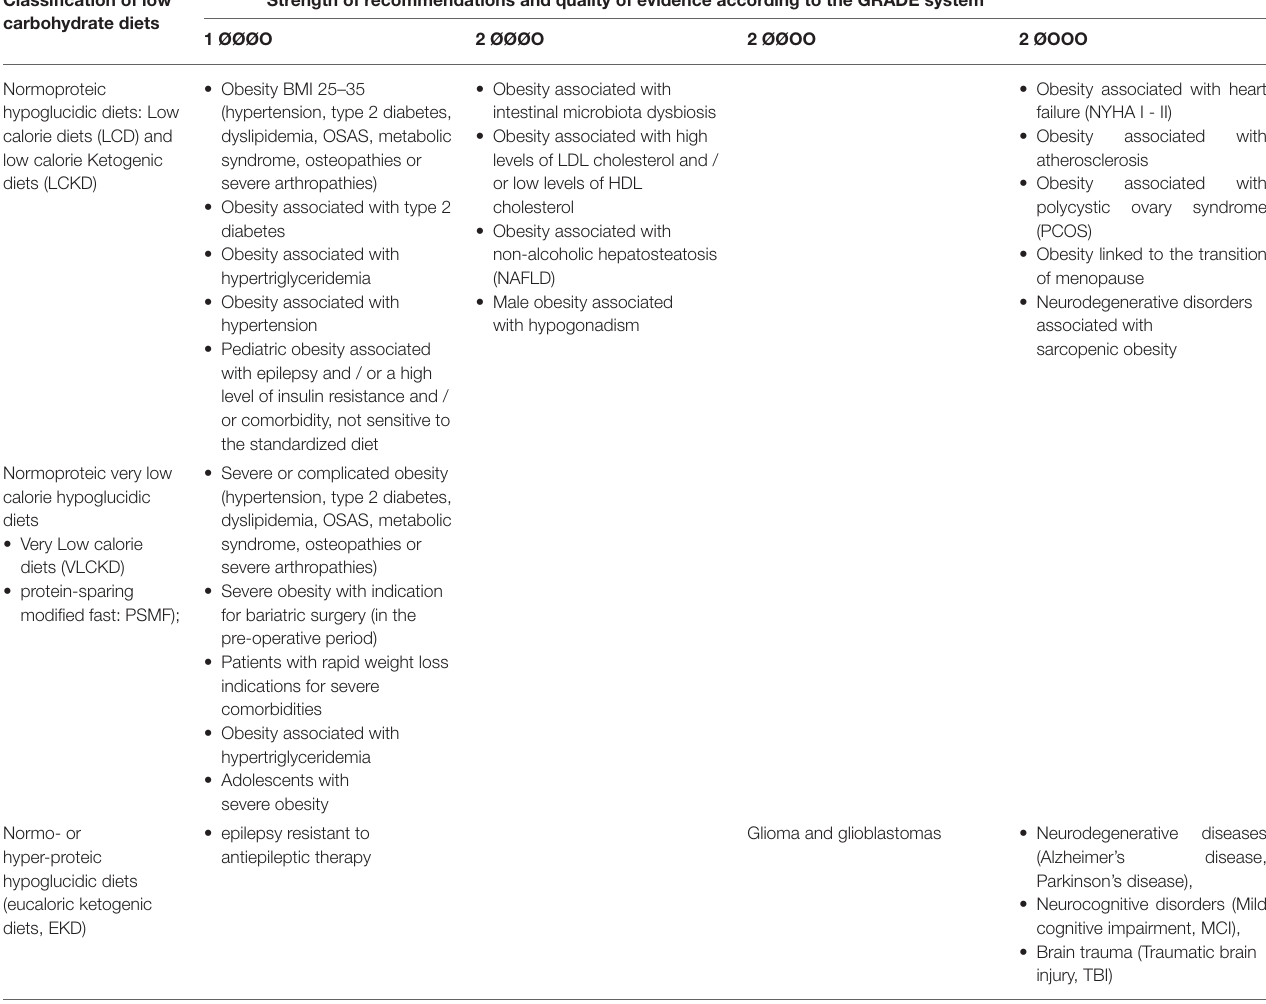
TABLE 1 | Classification of low carbohydrates diets and strength of the recommendations for their use. Classification of low Strength of recommendations and quality of evidence according to the GRADE carbohydrate diets